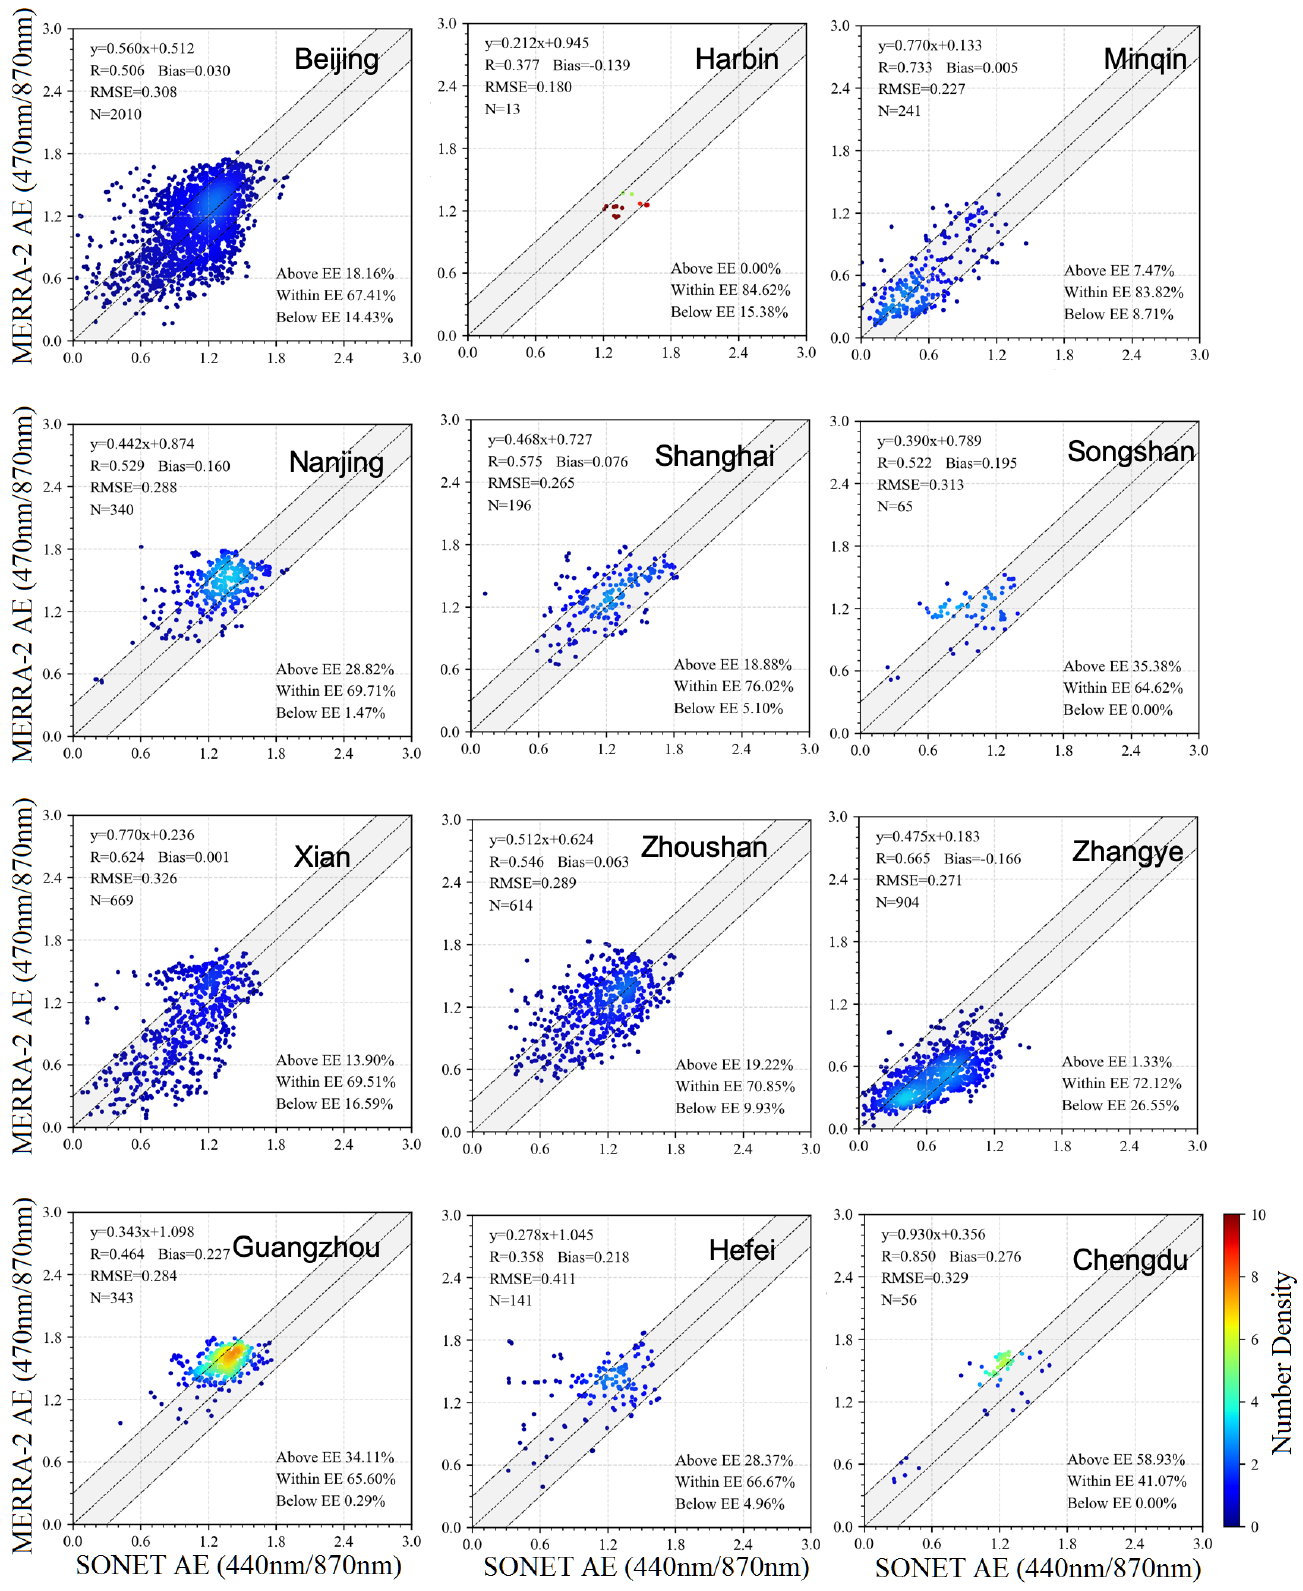
Figure 4. Same as Figure.2, but for AE.